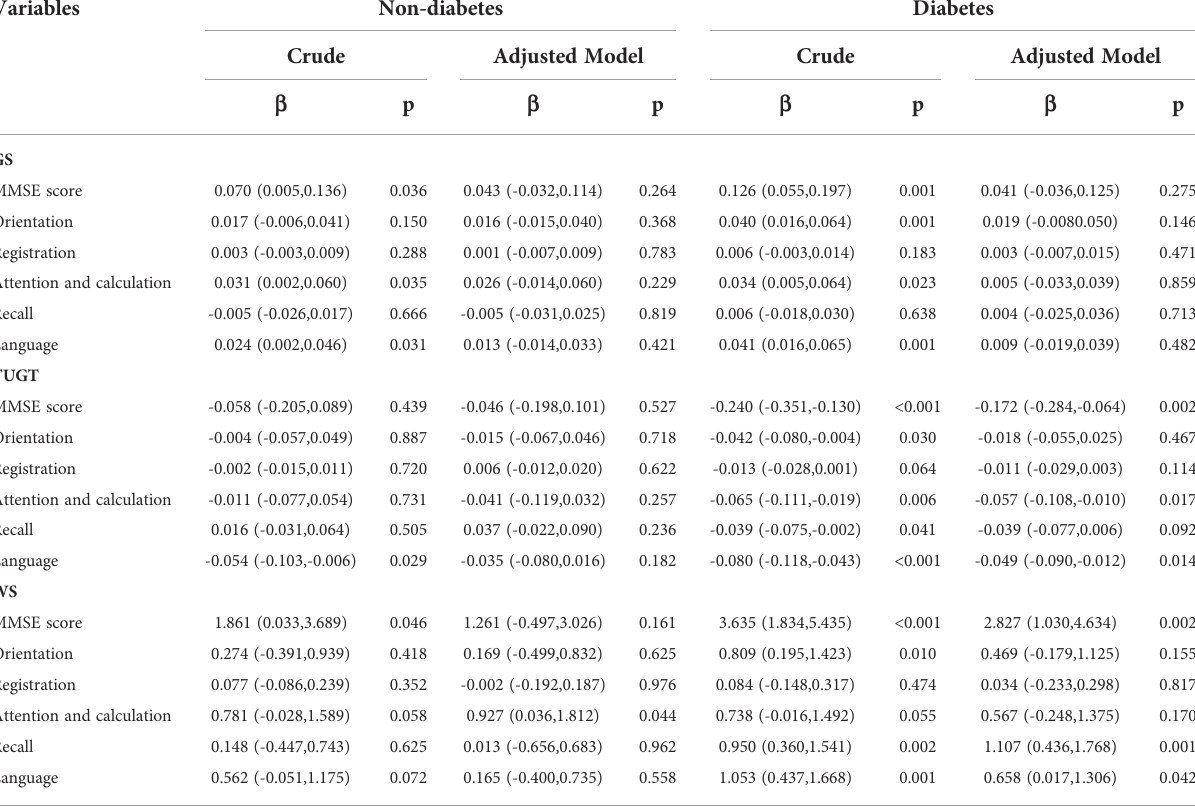
TABLE 3 Multivariate linear regression analysis of the association between physical performance and cognitive functions in the non-diabetic and diabetic hemodialysis patients.